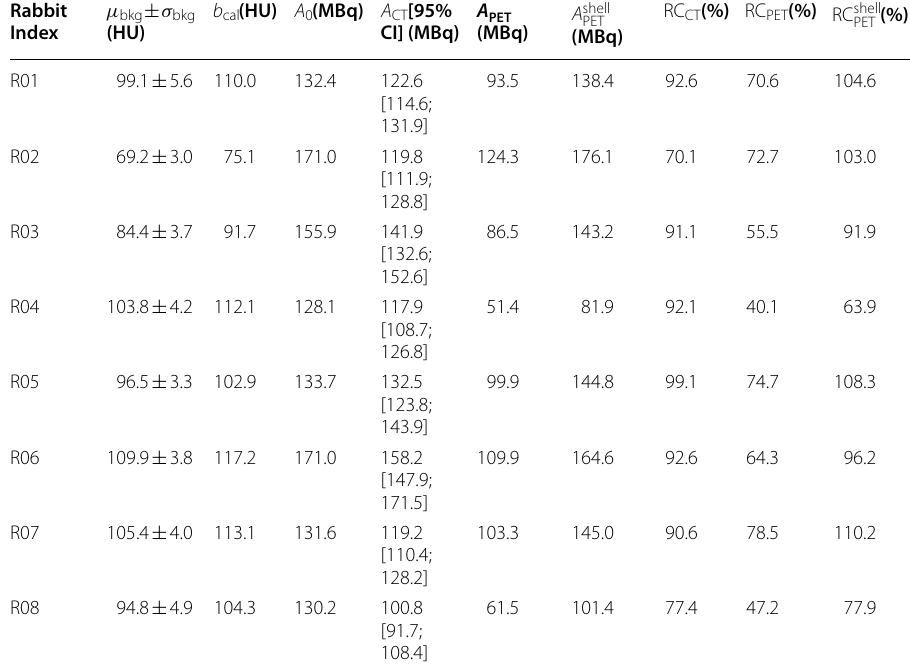
Table 1 Average voxel values in the background region, calibration curve intercepts, activity parameters, and recovery coefficients for all rabbits Rabbit Index